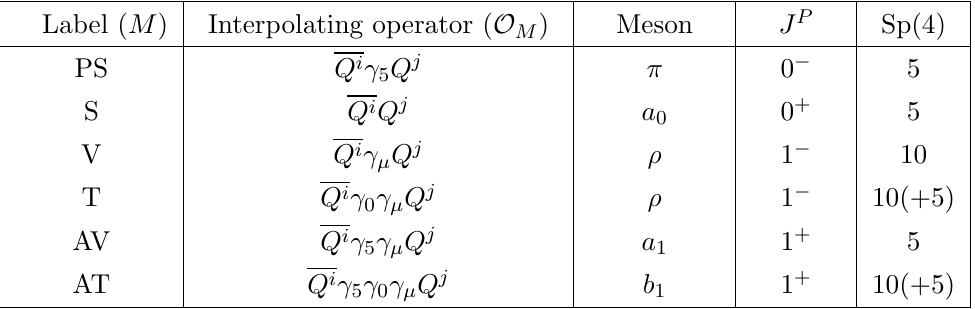
Table 5. Interpolating operators O M sourcing the lightest mesons in the six channels considered in the main text. To avoid mixing with the (cid:13)avour singlets, we restrict to i 6 = j the (cid:13)avour indices of the Dirac fermions, while colour and spinor indices are summed and omitted. For completeness, we also show the J P quantum numbers and the corresponding particle in the QCD classi(cid:12)cation of mesons. Notice that two of the operators source the same particles ( (cid:26) meson) because of the breaking of chiral symmetry. In the last column we report the irreducible representation of the unbroken global Sp(4) spanned by the meson (see also [43]). In brackets are irreducible representations of Sp(4) that are sourced by operators with the same Lorentz structure, but that we do not discuss in this